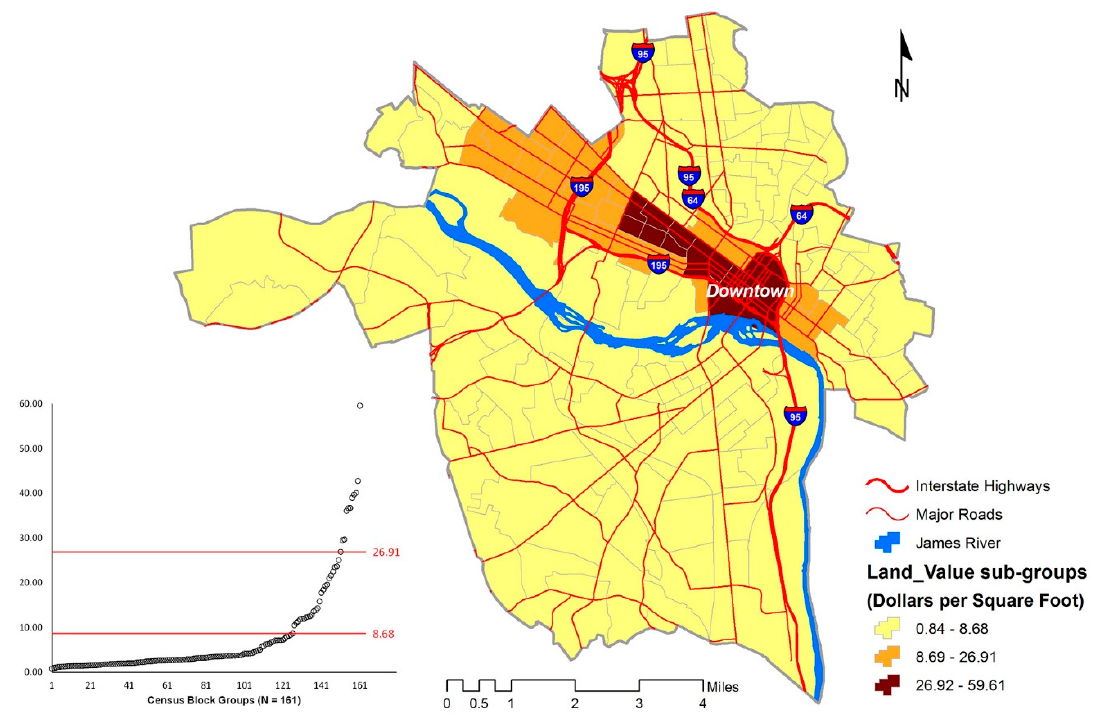
Figure 11. Sub-groups of low, medium, and high land values in the City of Richmond.